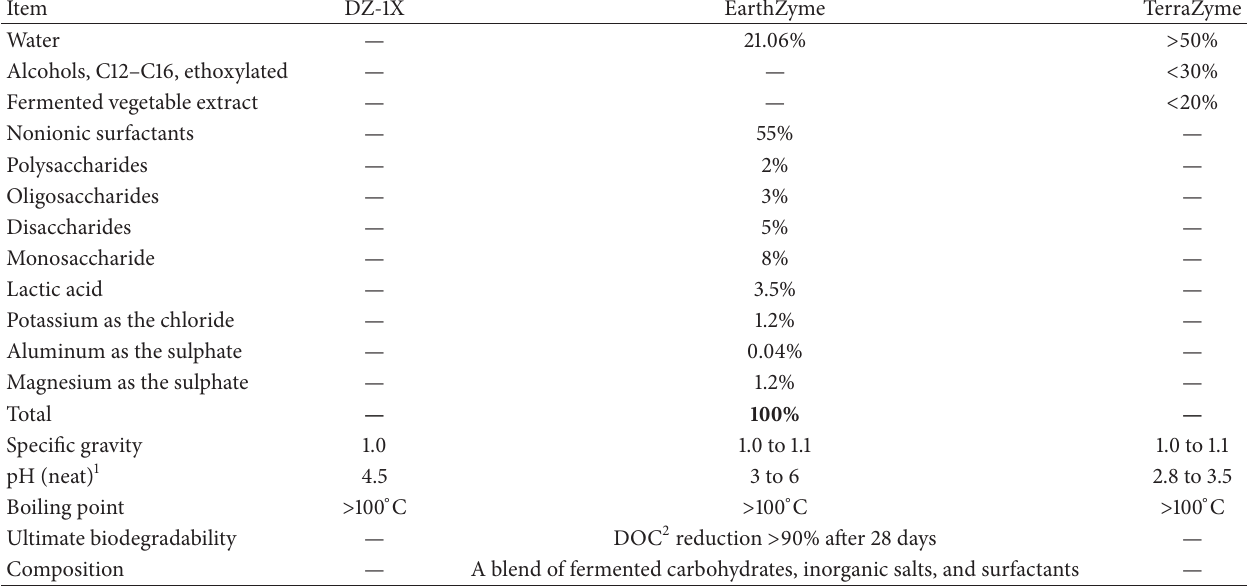
Table 1: Physical and chemical properties of enzymes.